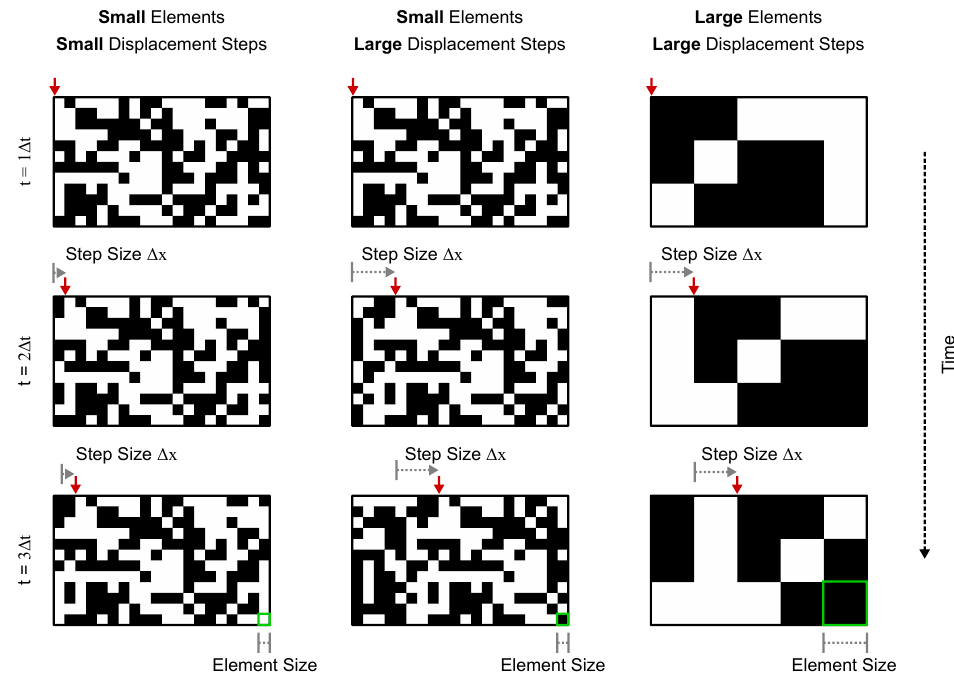
Figure 1. Examples of the random chequerboard pattern stimuli used in the experiment. Each column of panels shows still frames of a random chequerboard pattern that moves across a screen. The pattern is displaced by a fixed step ( ∆ x ) on ∆ t intervals where the speed v = ∆ x / ∆ t is constant (the red arrow at the top of each panel points to a reference point for easier visualization). The perception of motion in these patterns is strongly dependent on the displacement step ( ∆ x ) relative to the pattern’s chequer/element size. When ∆ x is comparable to the element size, humans perceive the pattern as moving smoothly and can identify its direction reliably ( column 1 ). Increasing ∆ x causes the pattern motion to appear more “jerky” and makes its direction harder to identify ( column 2 ). Because the perception of motion is dependent on the ratio between the element and step size, increasing the element size to match the step size makes the patterns appear to be moving smoothly again ( column 3